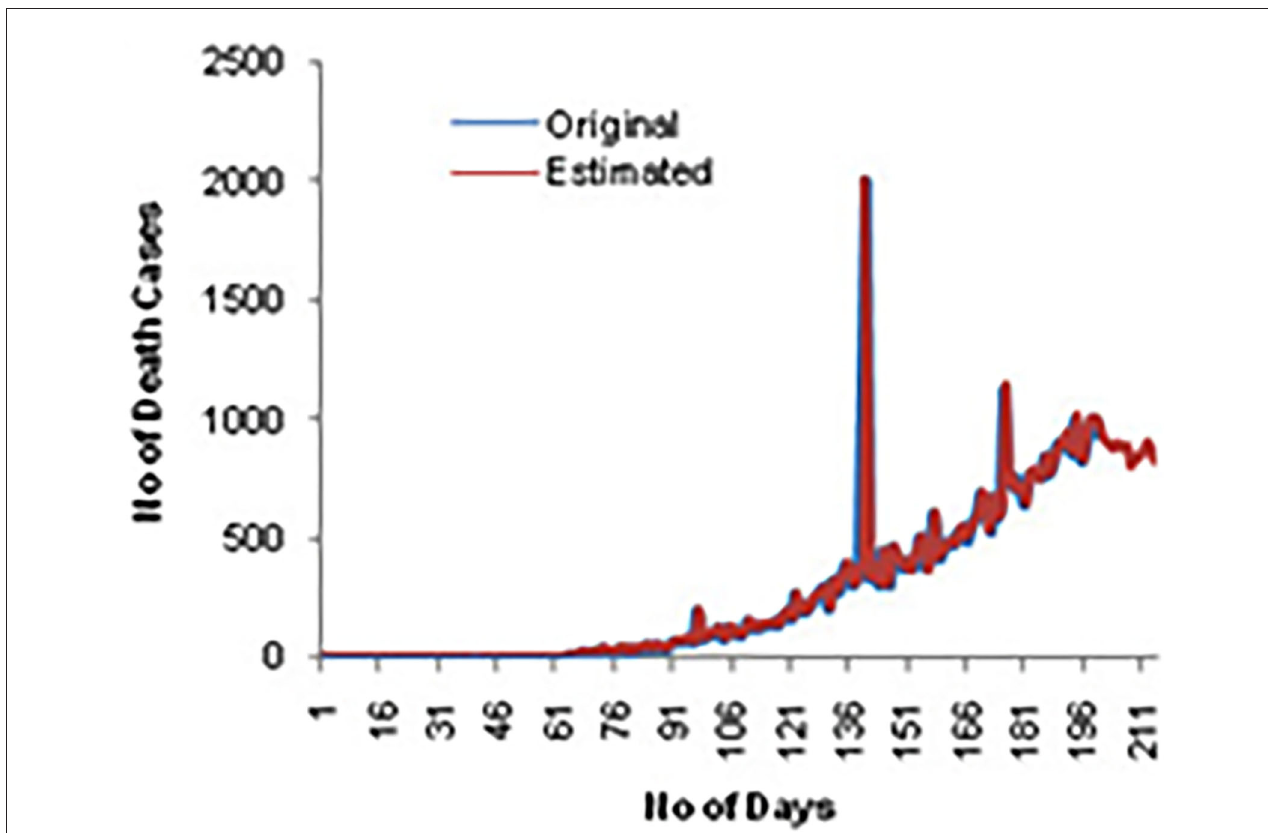
FIGURE 7 | Death case estimated for next 15